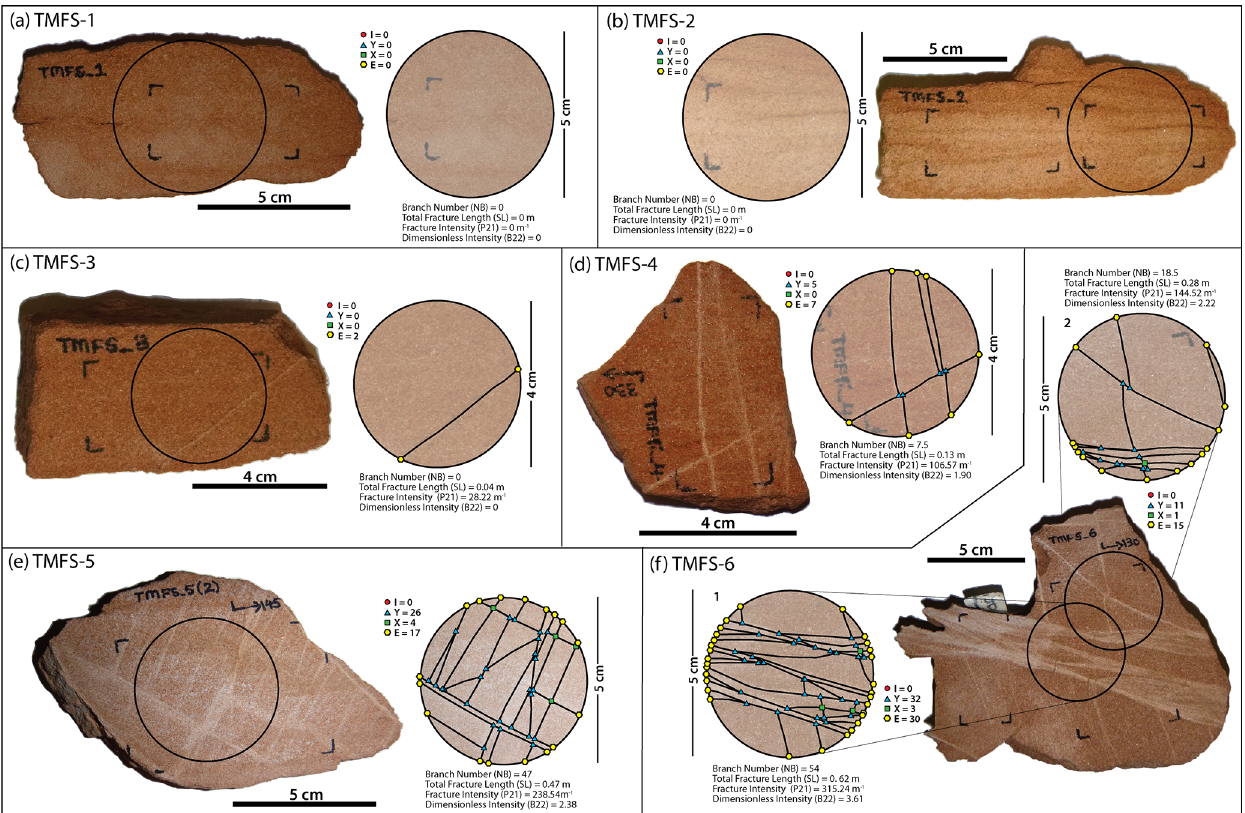
Figure 3. Fracture analysis of hand specimens. (a–f) Bedding-normal cut surfaces with hand-specimen photographs showing fracture analysis circles for each structural station (note, sample numbers correspond to their respective station). Fracture analysis was carried out on freshly cut surfaces. Circular scans show the fracture network and associated I-, Y-, X- and E-nodes (for explanation of terminology see Fig. 4 and Sanderson and Nixon, 2015). Statistics show total number of branches ( N ), total fracture length (SL), fracture density/intensity ( P 21 ), and branch dimensionless intensity ( B 22